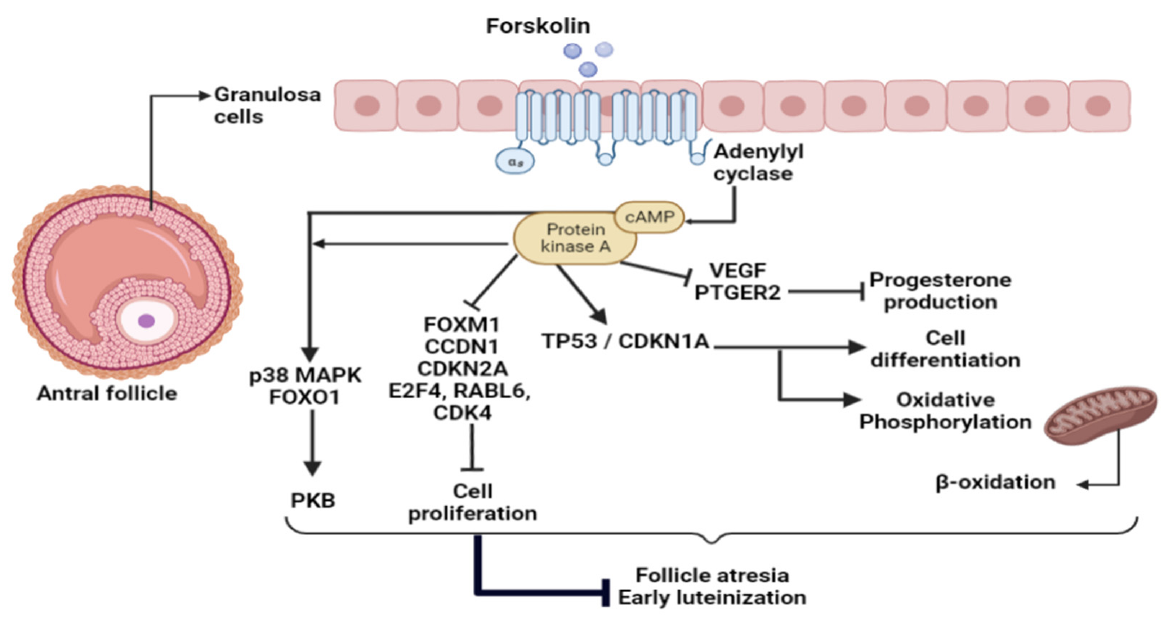
Figure 2. FSK effects on follicular development at the antral stage.